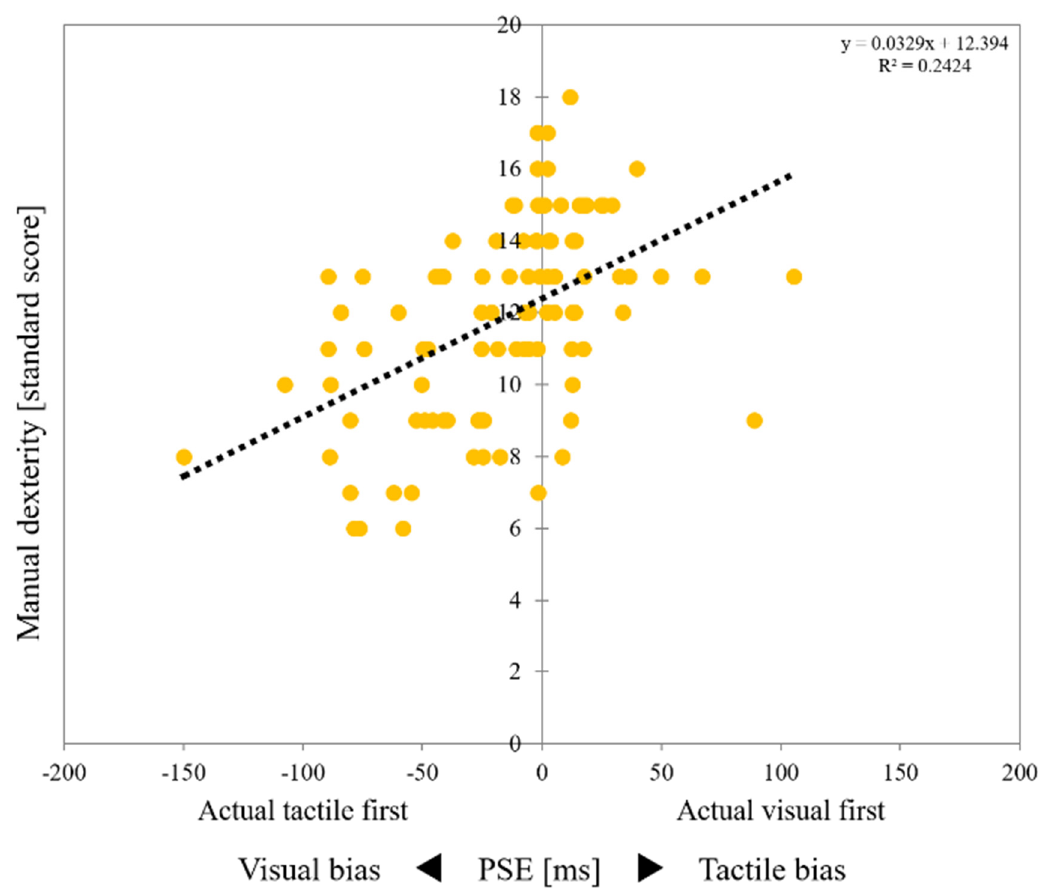
Figure 2. Correlation between perceptual bias and manual dexterity. Scatter plot showing the relationship between the temporal order judgment task and manual dexterity test. The vertical axis shows the results of the manual dexterity test (standard score) of each child. An increase in the standard score indicates an improvement in manual dexterity. The horizontal axis shows the results of the temporal order judgment task (PSE) for each child. Negative PSE values on the horizontal axis represent “visual first” indicators that were higher although the tactile stimulus was actually faster than the visual stimulus. Thus, an increase in the negative PSE value represents an increase in visual bias. Conversely, positive PSE values on the horizontal axis represent the “visual first” indicators when the visual stimulus was actually earlier than the tactile stimulus. Thus, an increase in the positive PSE value represents an increase in tactile bias. Therefore, the closer the PSE value is to 0 (middle line), the lower the perception bias. PSE, point of subjective equality.